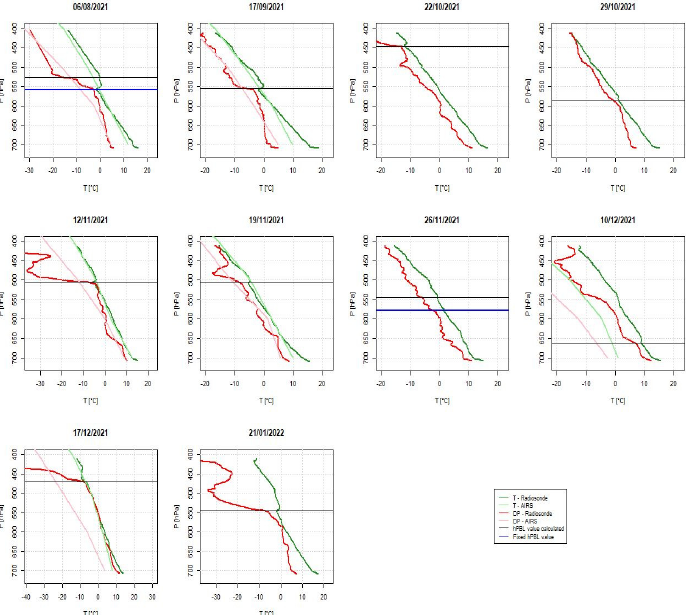
Figure 11. Temperature and dewpoint temperature pressure profiles from radiosonde and AIRS with the calculated hPBL value for ten measurement events.